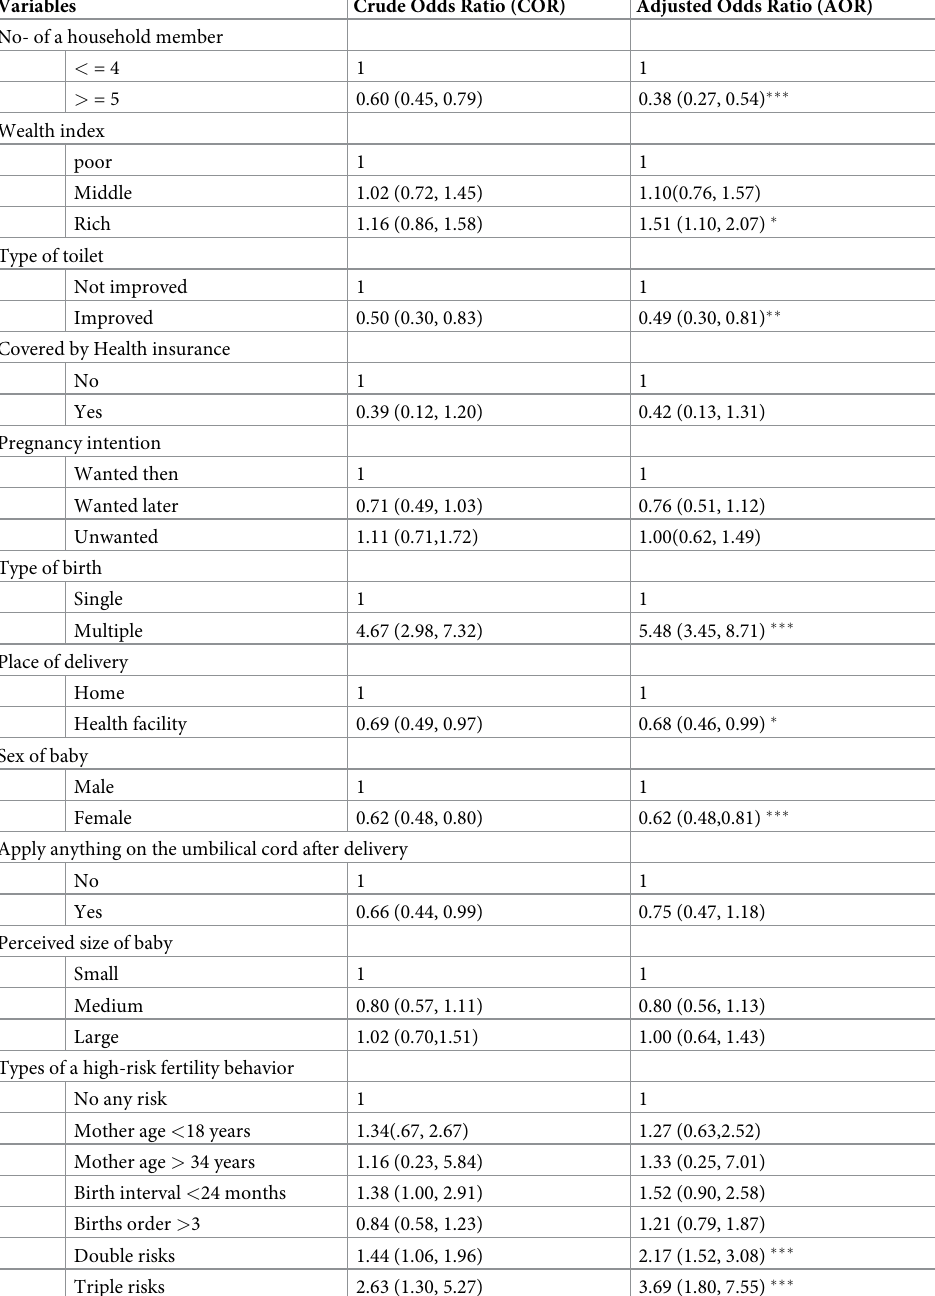
Table 2. Bivariate and multivariate association between high-risk fertility behaviors in women aged 15–49, other characteristics, and under-five mortality, EDHS 2016. Variables Crude Odds Ratio (COR) Adjusted Odds Ratio